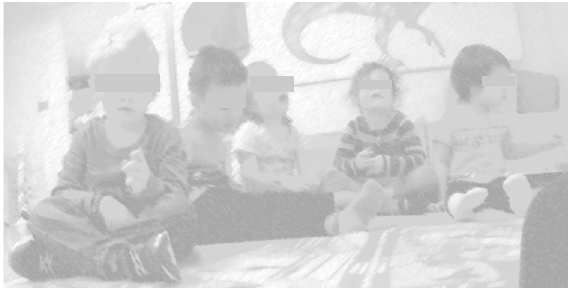
Figure 2. Body language in one instance of the first activity. Table 2. A summary of the indicators for inhibitory control. IC (Body Language) Shifting focus to the surroundings (picking up items) Moving around (jumping, standing, dancing) Moving close to the teacher Eye contact with the teacher and little movement